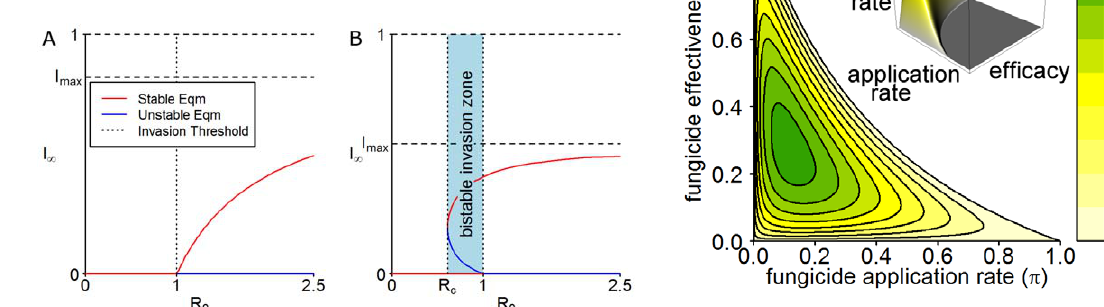
Figure 2. Model bifurcation diagrams. Bifurcation diagrams for the implicit and explicit models showing the effect of explicitly including fungicide dynamics on the endemic equilibria of the system. (A) The implicit model only admits bifurcation diagrams with a single invasion threshold at R 0 ~ 1 . (B) The explicit model can additionally admit a bistable invasion zone. Within this zone invasion depends upon the initial level of infection ( I 0 ). The default parameters used for these plots are given in Table 2.